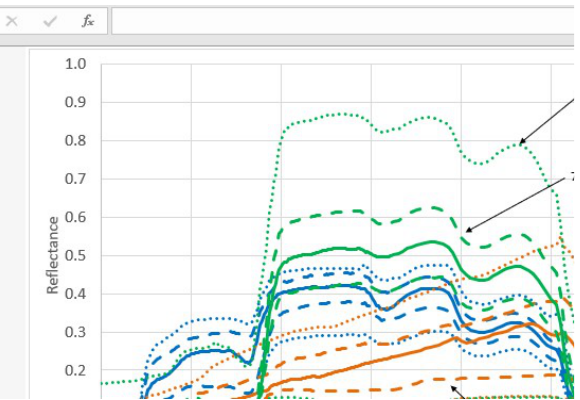
Figure 3. Range and median of spectra for the three groups The first stage of separation analysis, an ANOVA assessment for dimensionality reduction, was performed on the three groups of spectra using a custom Python script, testing the null hypothesis that there was no statistically significant difference between the means of each pair of groups (results in Figure 3).